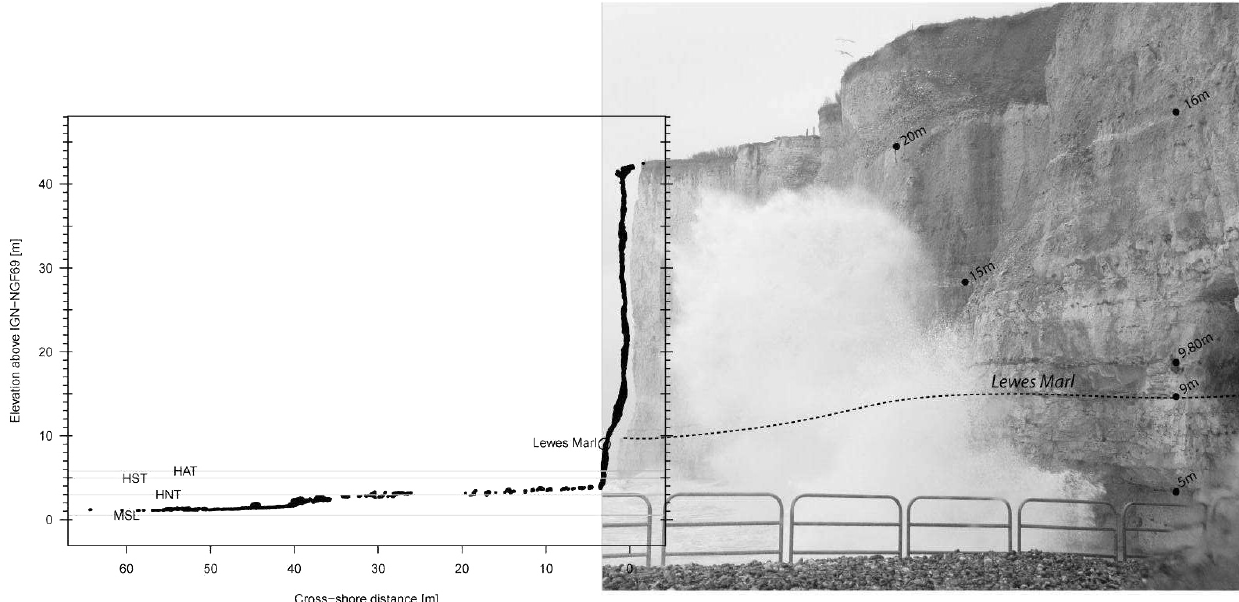
Figure 11. View of a sea wave breaking on the Mesnil-Val chalk cliff (looking north towards Le Tréport harbour) during high tide, photo T. Dewez, 20 March 2007. The left panel depicts laser-scanner-derived cross section of the cliff at the same place with indications of highest astronomical tide level (HAT), high spring tide level (HST), high neap tide level (HNT), and mean sea level (MSL), along with the Lewes Marl geological marker